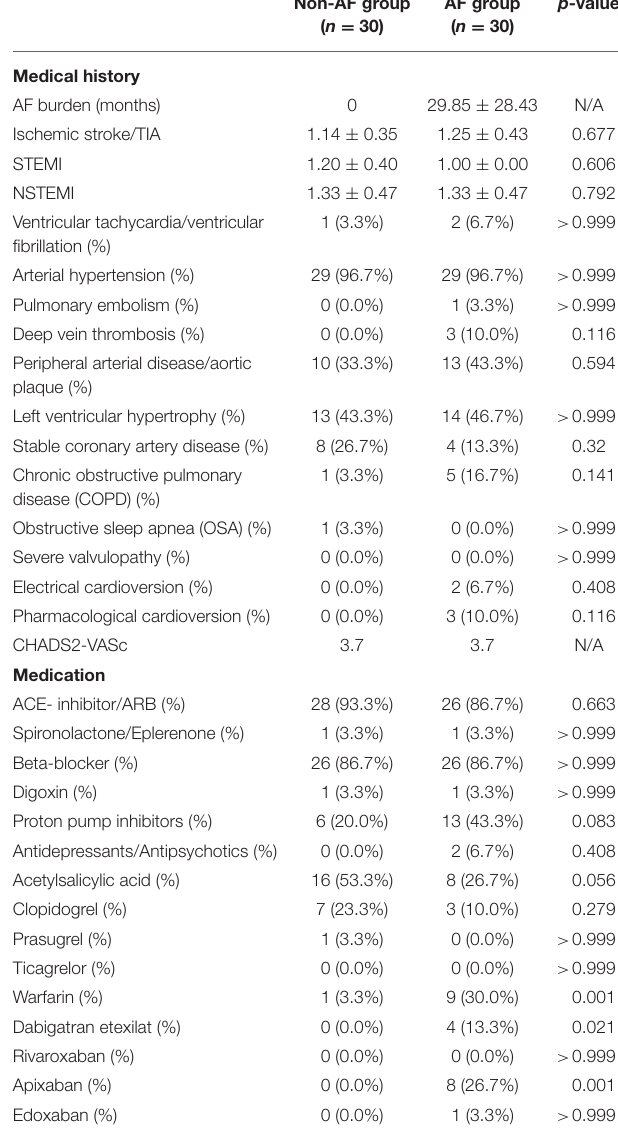
TABLE 2B | Patient characteristics: medical history and